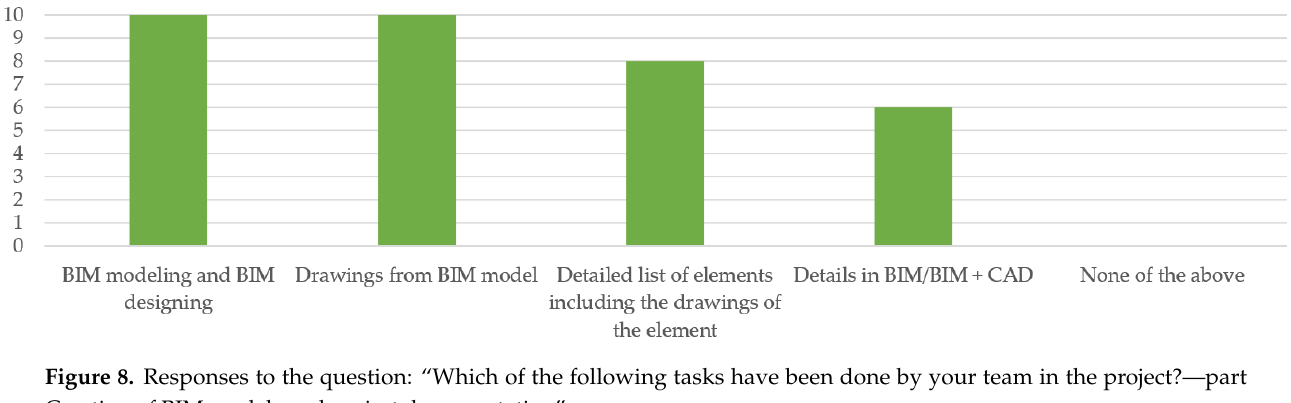
Figure 10. Responses to the question: “Which of the following tasks have been done by your team in the project? — part Communication, coordination, handover”. These data (Figures 6 – 10) are important because they are closely connected with time and staff consumption, of which the results are presented in Subsection 3.4. While some of the tasks (e.g., BEP preparation, change of model naming system) need to be completed and checked manually, many other tasks (e.g., collision distribution) can be done semi-